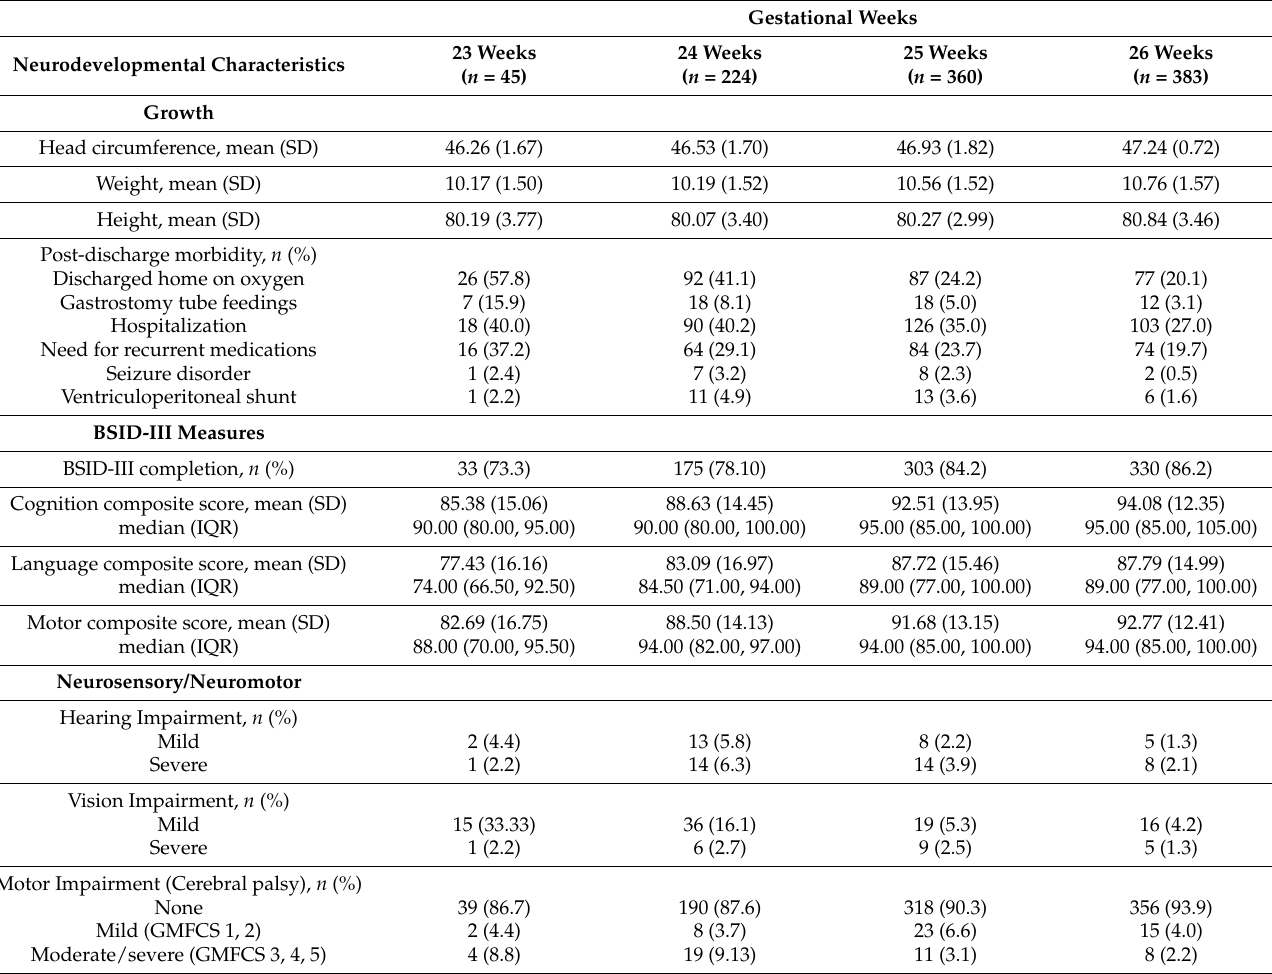
Table 3. Neurodevelopmental characteristics at 18–24 months corrected age of infants who were followed.